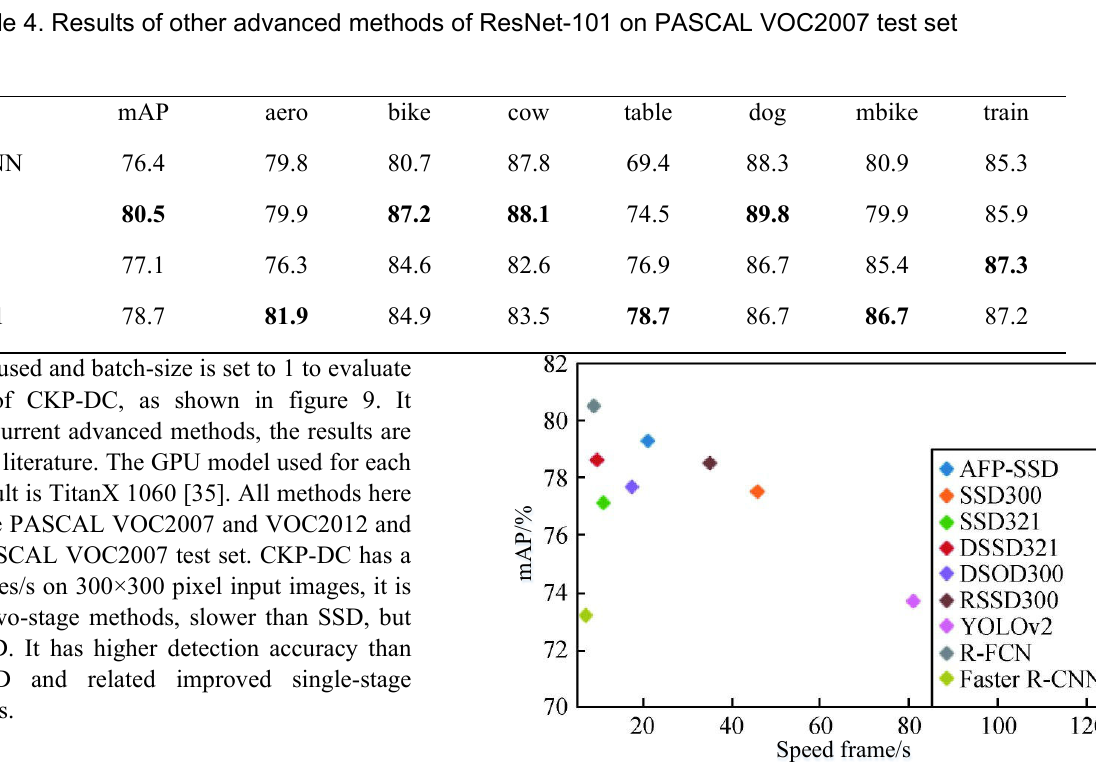
Table 4. Results of other advanced methods of ResNet-101 on PASCAL VOC2007 test set